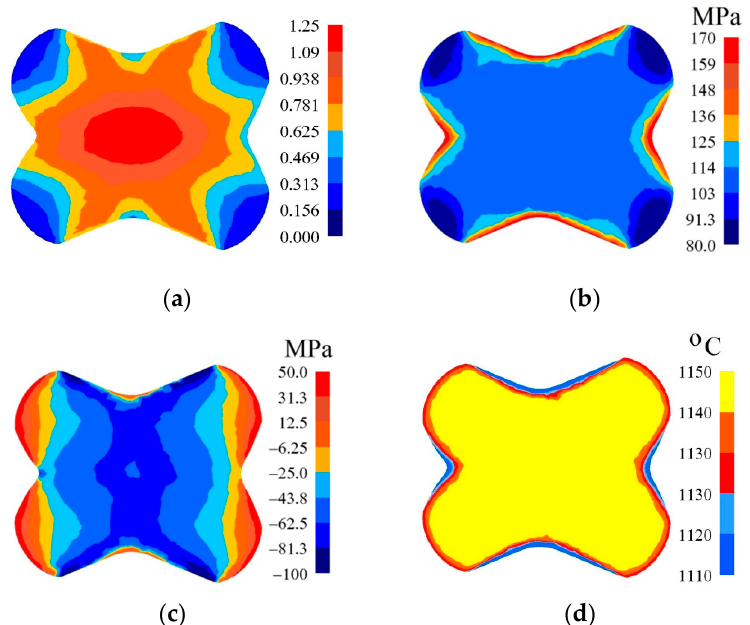
Figure 10. Distribution of the effective strain ( a ), effective stress ( b ), mean stresses ( c ), and temperature ( d ) on the cross-section of the workpiece in the course of forging in convex anvils after the second pass ( α c = 135°, ε c = 0.51).